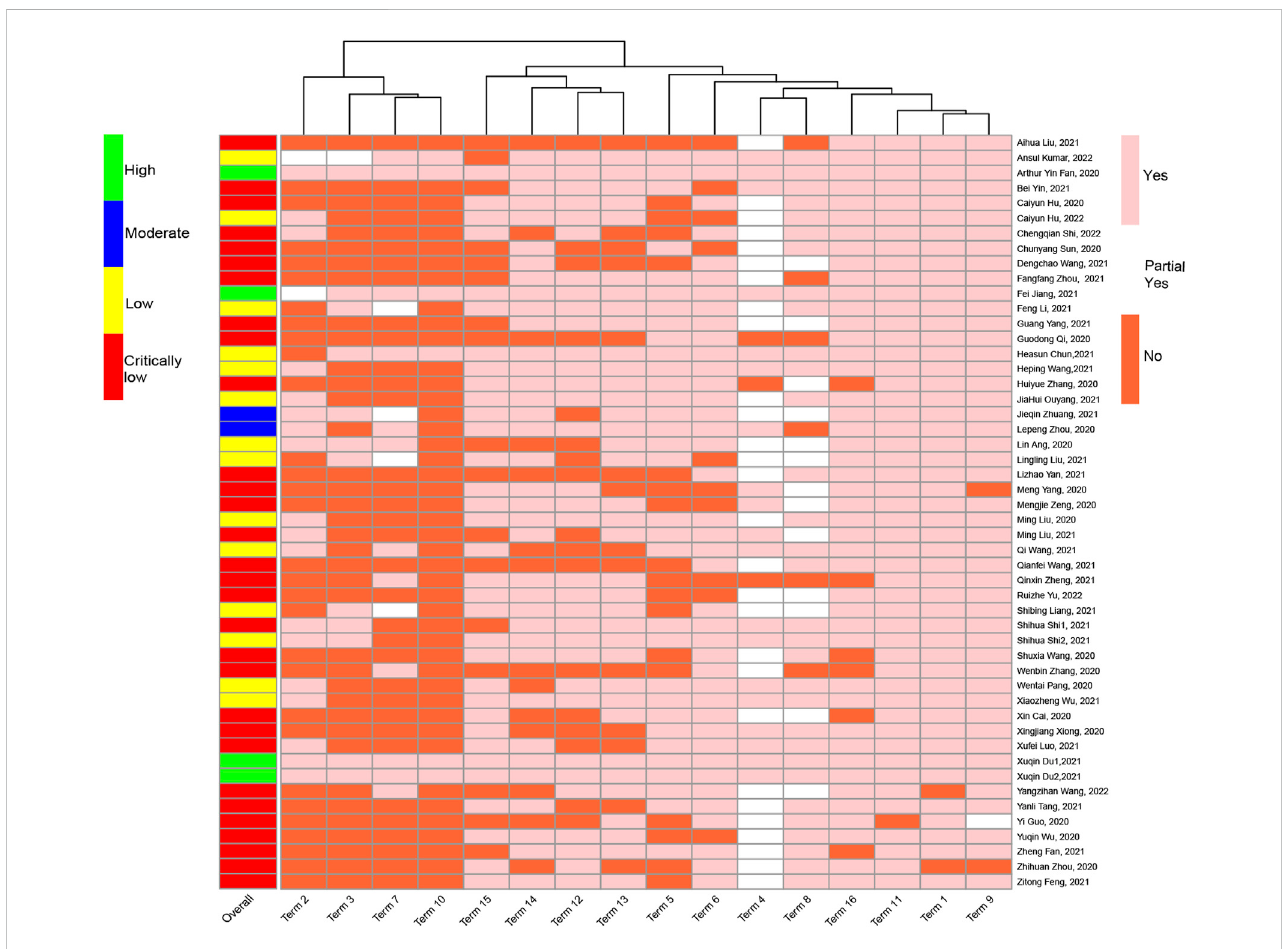
FIGURE 3 Methodological quality assessment of the included 50 systematic